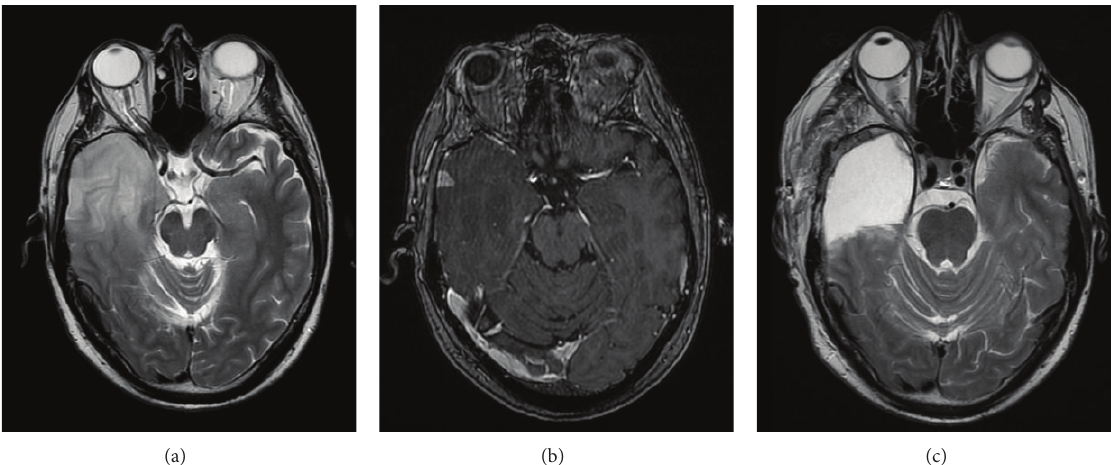
Figure 1: Pre- and Post-Operative Glioblastoma Imaging. (a) Pre-operative axial T 2 -weighted image. (b) Pre-operative gadolinium-enhanced T 1 -weighted image. (c) Post-operative axial T 2 -weighted image.